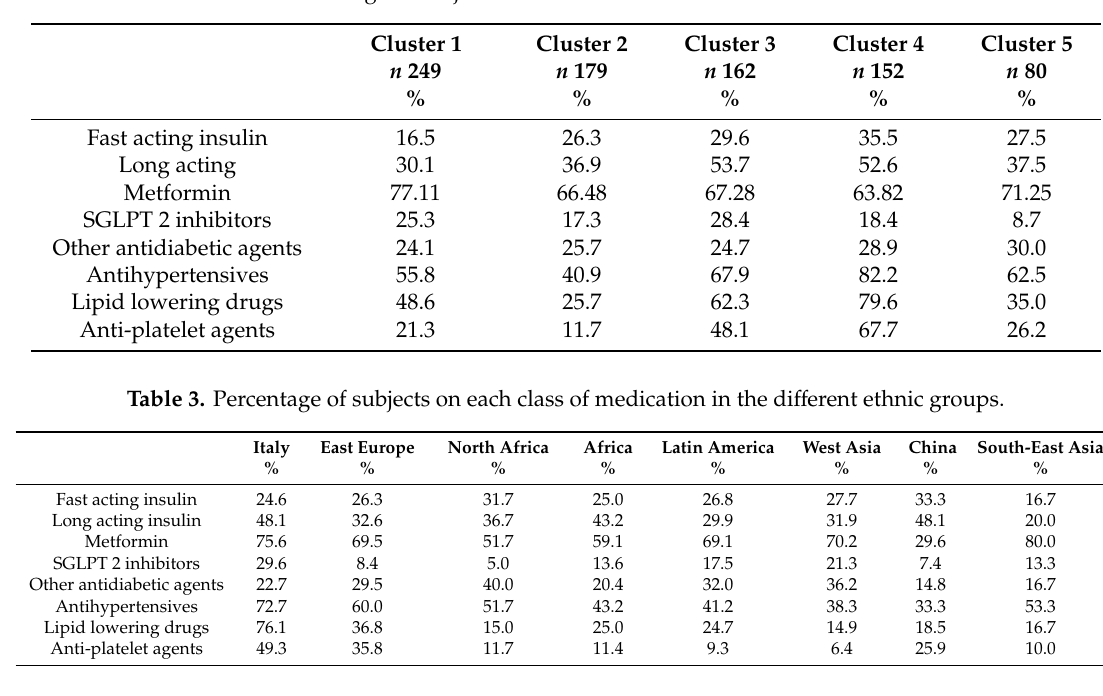
Table 2. Percentage of subjects on each class of medication in the 5 clusters.